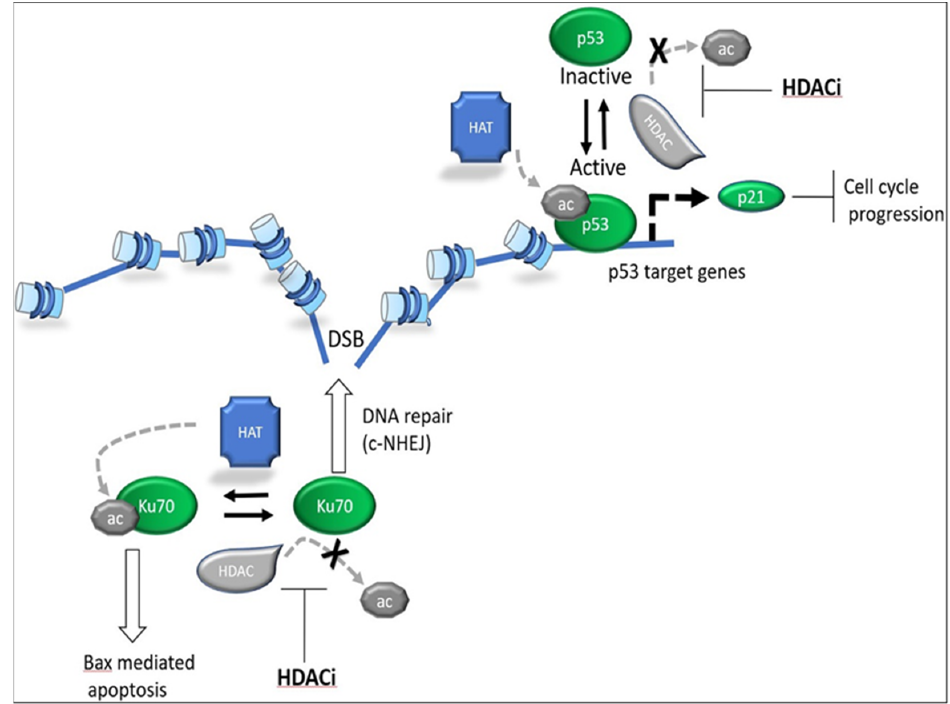
Figure 4. Deacetylation of p53 (e.g., at K373/K382) and Ku70 by histone deacetylases (HDACs) regulates tumor cell proliferation and DNA damage repair. DSB: double-strand break; HAT: histone acetyltransferase; c-NHEJ: canonical non-homologous end-joining. Cell cycle . A major effect of HDAC inhibitors in cells is activation of tumor suppres- sor pathways and blocking of cell cycle progression. Cell cycle progression is tightly reg- ulated to ensure homeostasis, and its obstruction can lead to senescence, apoptosis, and other forms of cell death. The activities of major tumor suppressors such as p53 and p21 are tightly linked to cell cycle regulation [114].